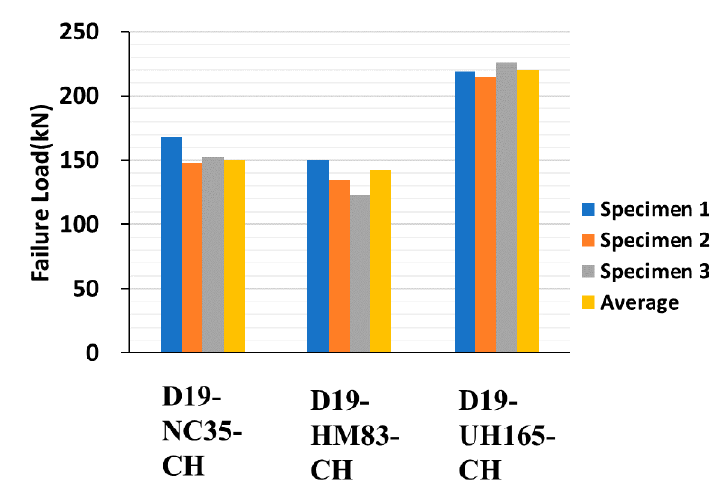
Figure 16. Pull-out test results of 16 mm GFRP rebars (normal concrete, mortar, UHPC).